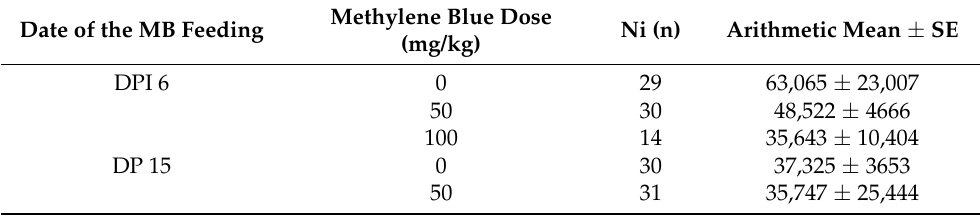
Table A3. Sporozoite intensity was estimated by counting the number of sporozoites per mosquito after salivary glands dissection D21 post-infection. Ni, Number of mosquitoes in each treatment group. Day 6; p = 0.24 for mean oocysts comparisons of MB 50 mg/kg vs. control; p = 0.18 for comparisons of MB 100 mg/kg vs. control. Day 15; p = 0.17 for comparisons of MB 50 mg/kg vs. control. Date of the MB Feeding Methylene Blue Dose (mg/kg) Ni (n) Arithmetic Mean ± SE